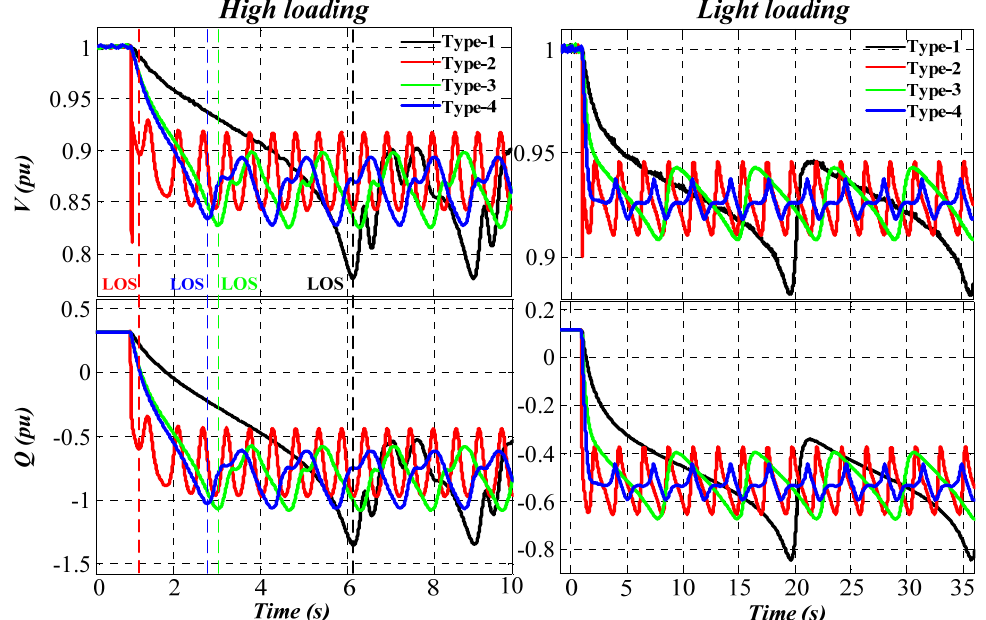
Figure 5. 𝑉 and 𝑄 variations during CLOE events in generator heavy loading (right column) and light loading (left column) conditions.